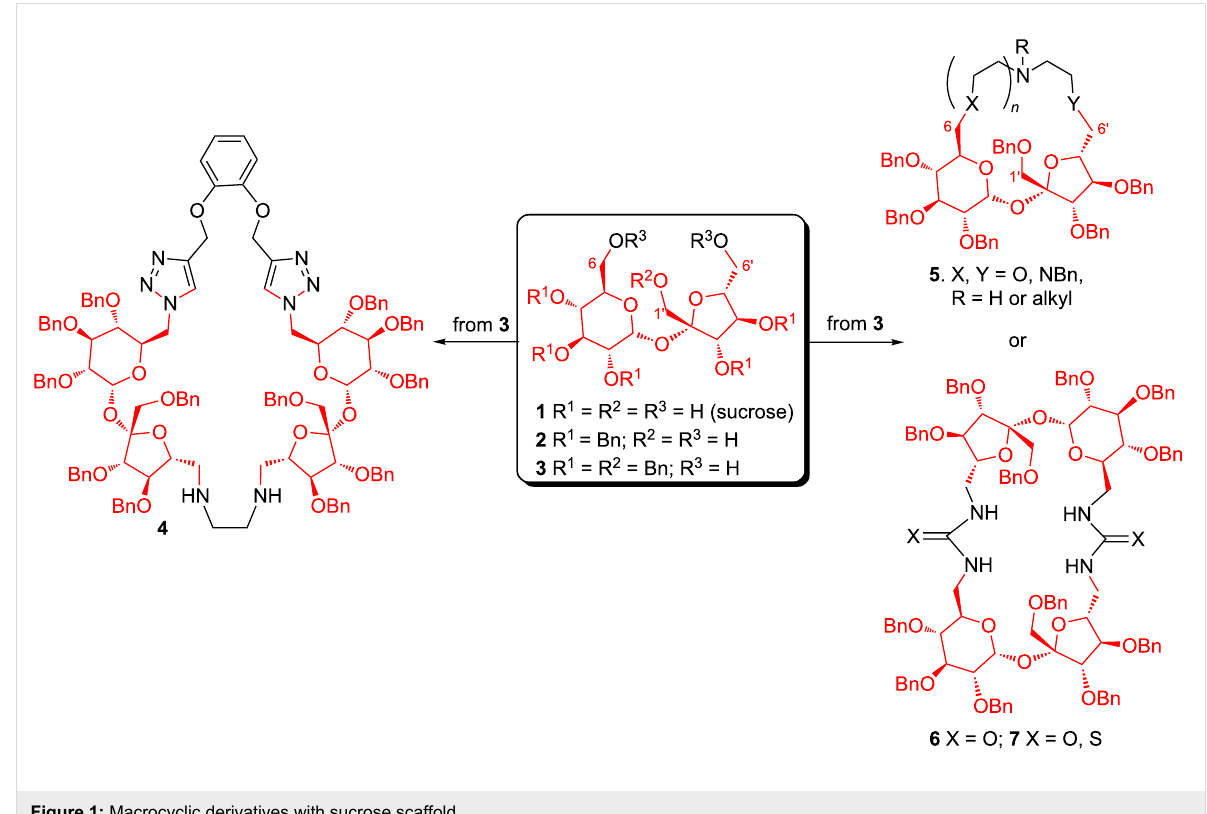
Figure 1: Macrocyclic derivatives with sucrose scaffold.